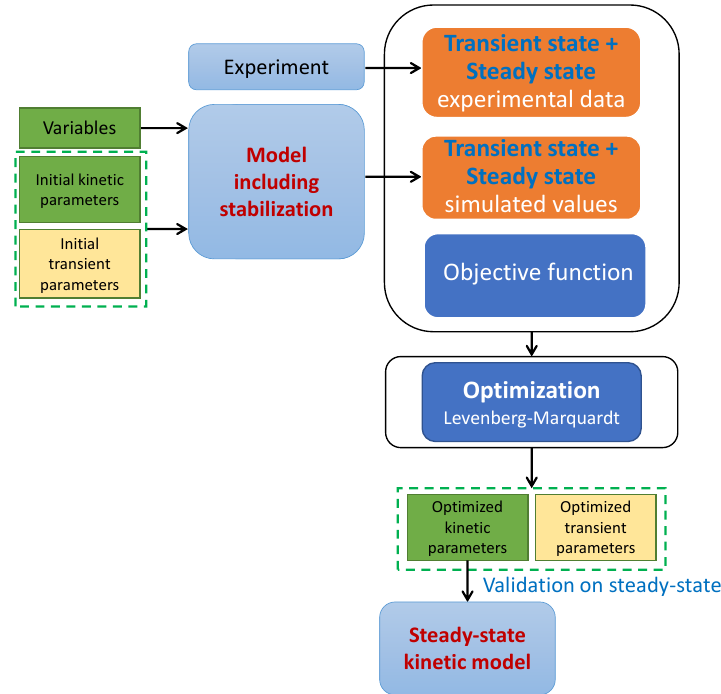
Figure 12. Parameter estimation framework for the “model including stabilization”.